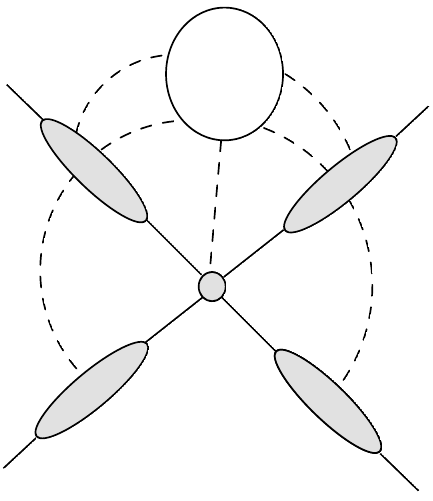
Figure 1 . Depiction of a general pinch surface for two-to-two scattering. Shaded blobs represent jet subdiagrams, and the open circle a subdiagram of \soft" lines, whose momenta vanish at the pinch surface. In the center is a \hard" subdiagram consisting of lines o(cid:11)-shell by the order of the momentum transfer. Each line connecting the soft, jet and hard subdiagrams represents an arbitrary number of lines. For the purposes of this discussion, all lines are scalars, and the dashed lines simply represent soft lines attached to jet subdiagrams. Note the possibility that soft lines as well as jet lines attach to the hard